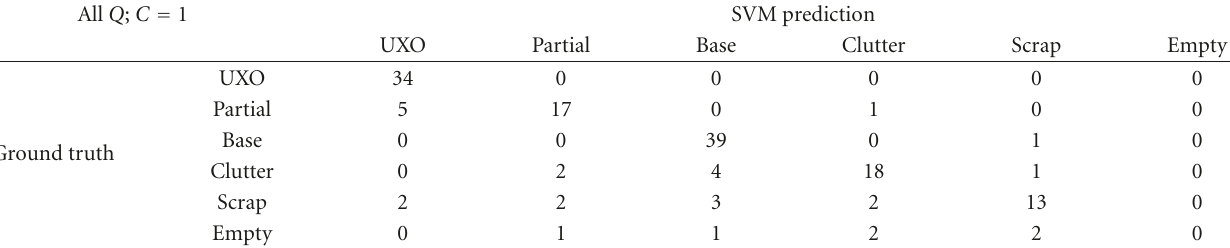
Table 5: SVM classification of Camp Sibert anomalies using all Q values (unscaled) with C =